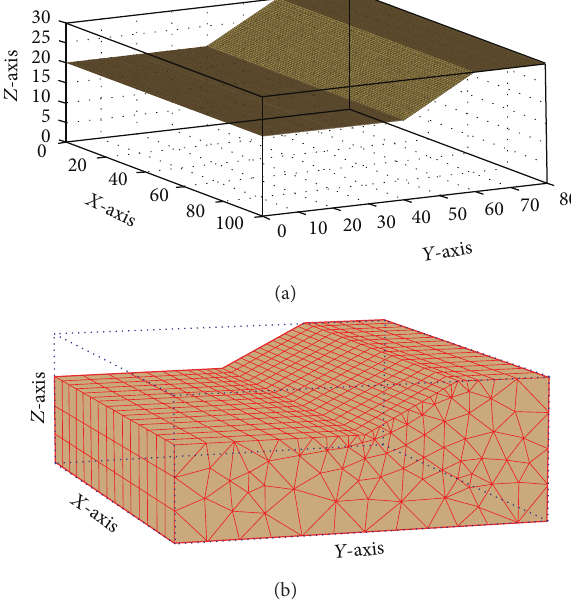
Figure 12: Generated 3D models of example problem 1 by (a) the present study and (b)